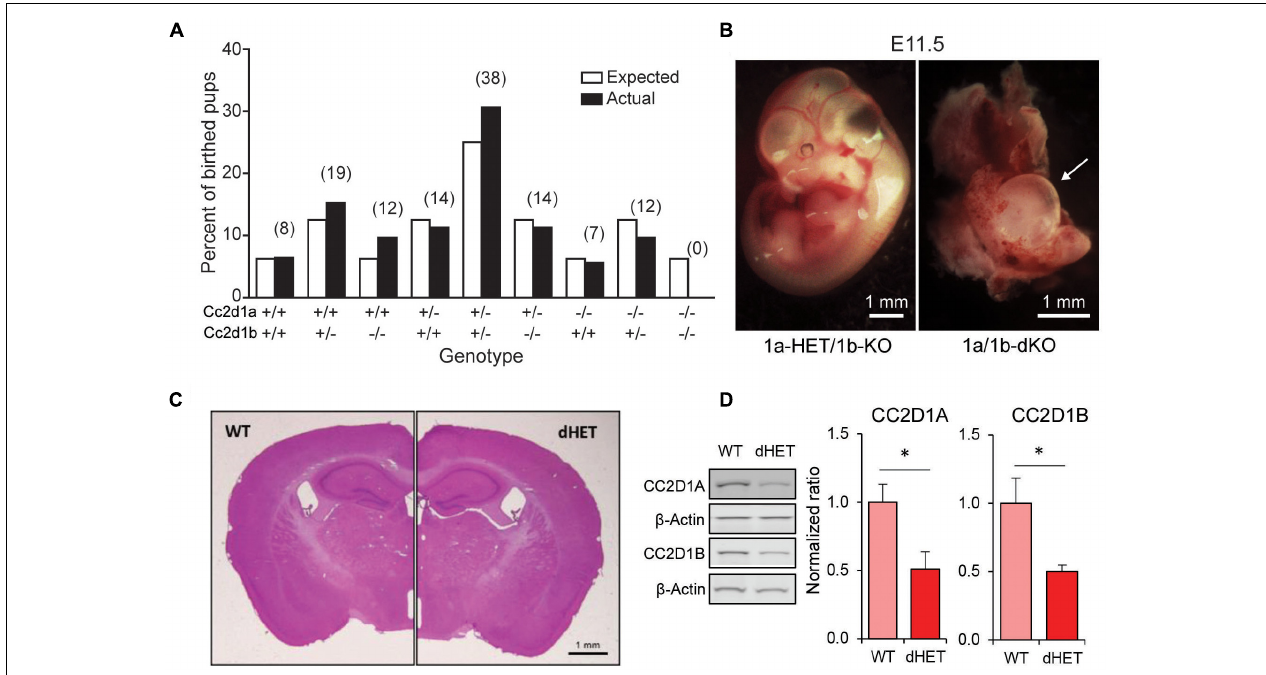
FIGURE 2 | Cc2d1a/Cc2d1b double LOF is embryonic lethal, while double heterozygotes are viable. (A) Genotypes at postnatal day 0 (P0) of 124 pups resulting from 22 double heterozygous (1a/1b-dHET) crosses (number of pups for each genotype indicated above in parentheses). The 1a/1b double knockout (A–/– B–/–) pups were never found at P0. (B) Representative images of normal embryonic day 11.5 (E11.5) embryo with a single intact Cc2d1 allele (Left) and a double KO embryo (Right; arrow indicates empty yolk sac). Scale bars: 1 mm. (C) The size and organization of the adult 1a/1b-dHET brain is indistinguishable from wild-type mice stained with hematoxylin and eosin. Scale bar: 1 mm. (D) Immunoblot analysis of CC2D1A and CC2D1B expression in wild-type and 1a/1b-dHET mice. A half dose of each CC2D1 protein was found. Results expressed as mean ± SEM. ∗ p < 0.05 (two tailed t -test).